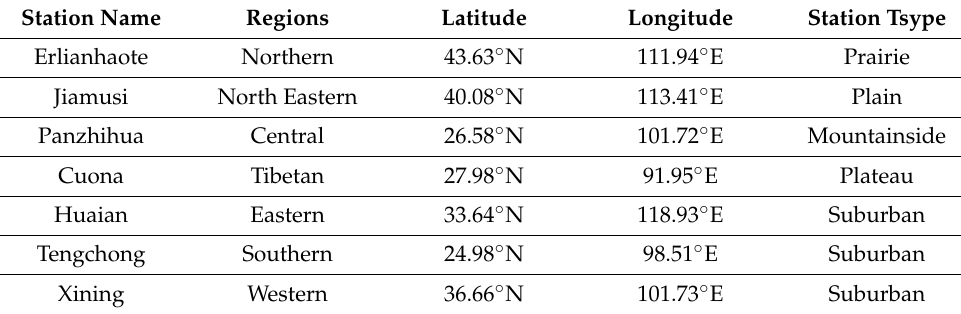
Table 4. The information of the 7 typical